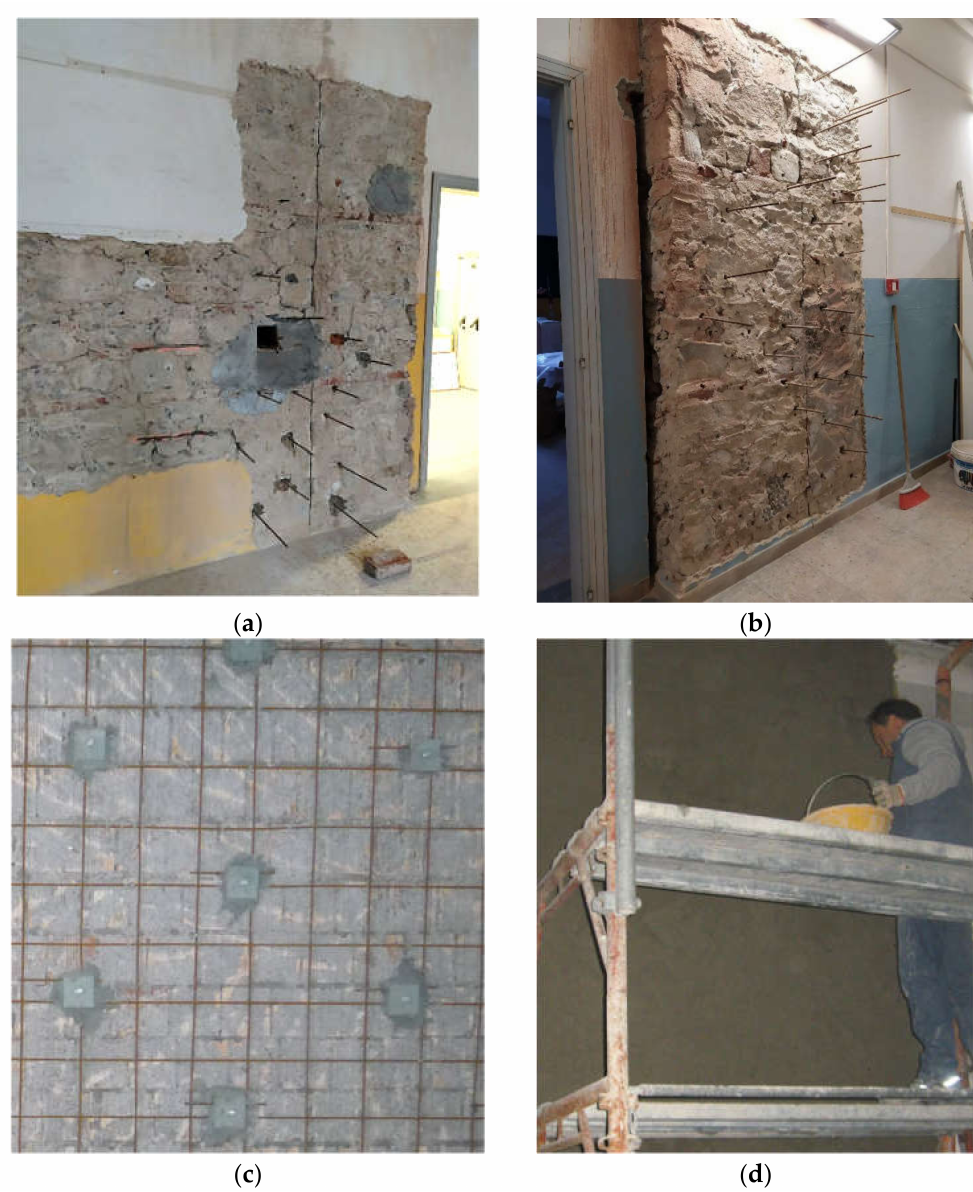
Figure 6. Strengthened technique adopted to restore the tested walls: repair of cut and cavity ( a ), insertion of threaded or reinforcing steel bars ( b ), application of the reinforcing steel mesh ( c ), and final grouting of the concrete layer ( d